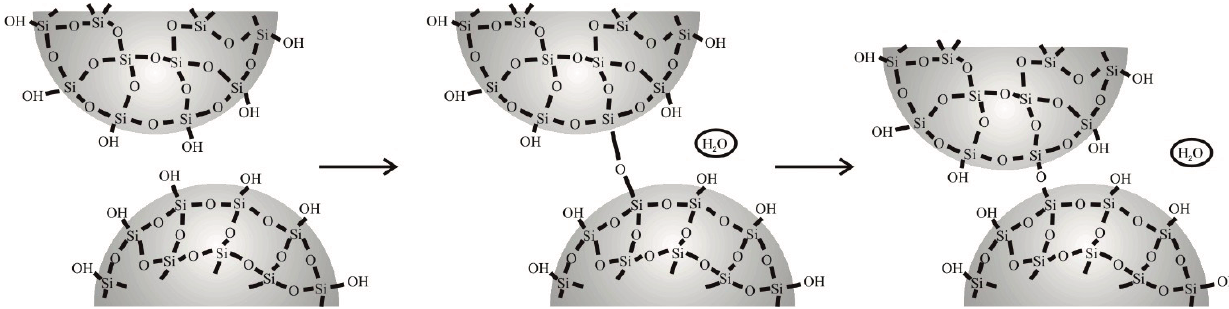
Figure 3. Schematic illustration of